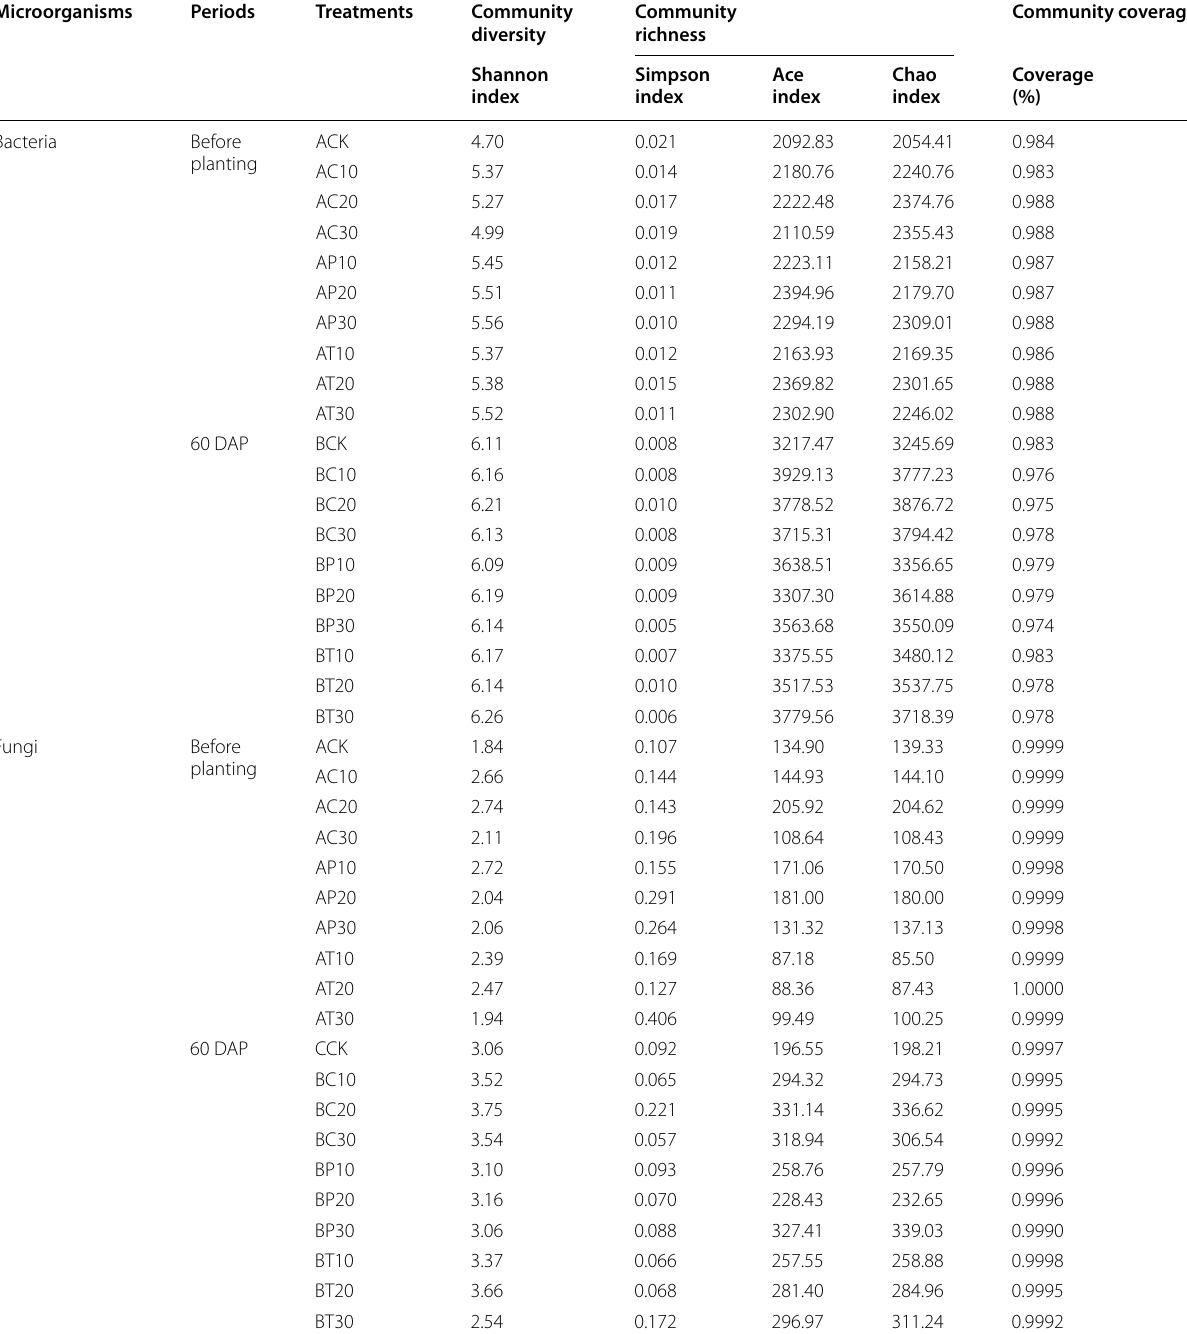
Table 4 Diversity analysis of soil microbial communities in different vegetable residues application Microorganisms Periods